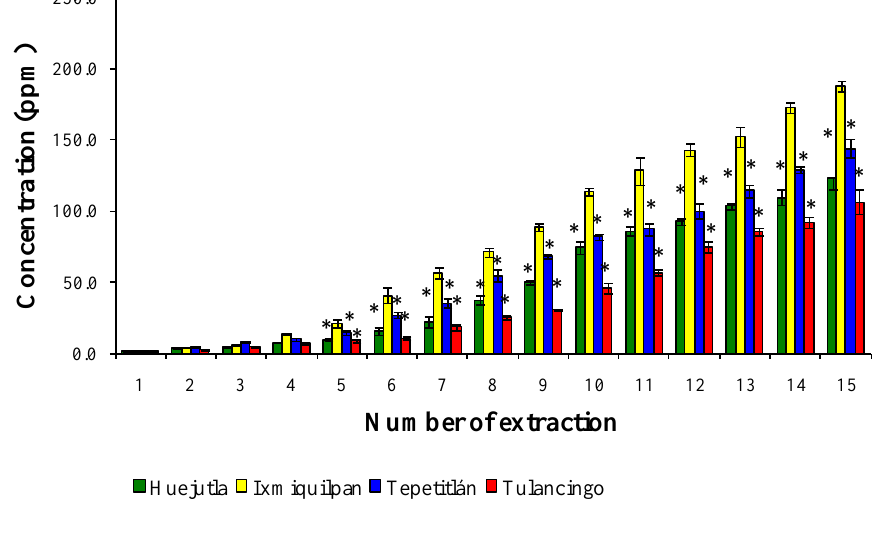
Figure 9. Concentration of Pb leached from glass-clay containers into acetic acid. The bars show the mean values of the four regions studied along with their standard deviations. * Indicates significant statistical differences with respect to the Ixmiquilpan regions, which represents the highest concentration of the metal; p ≤